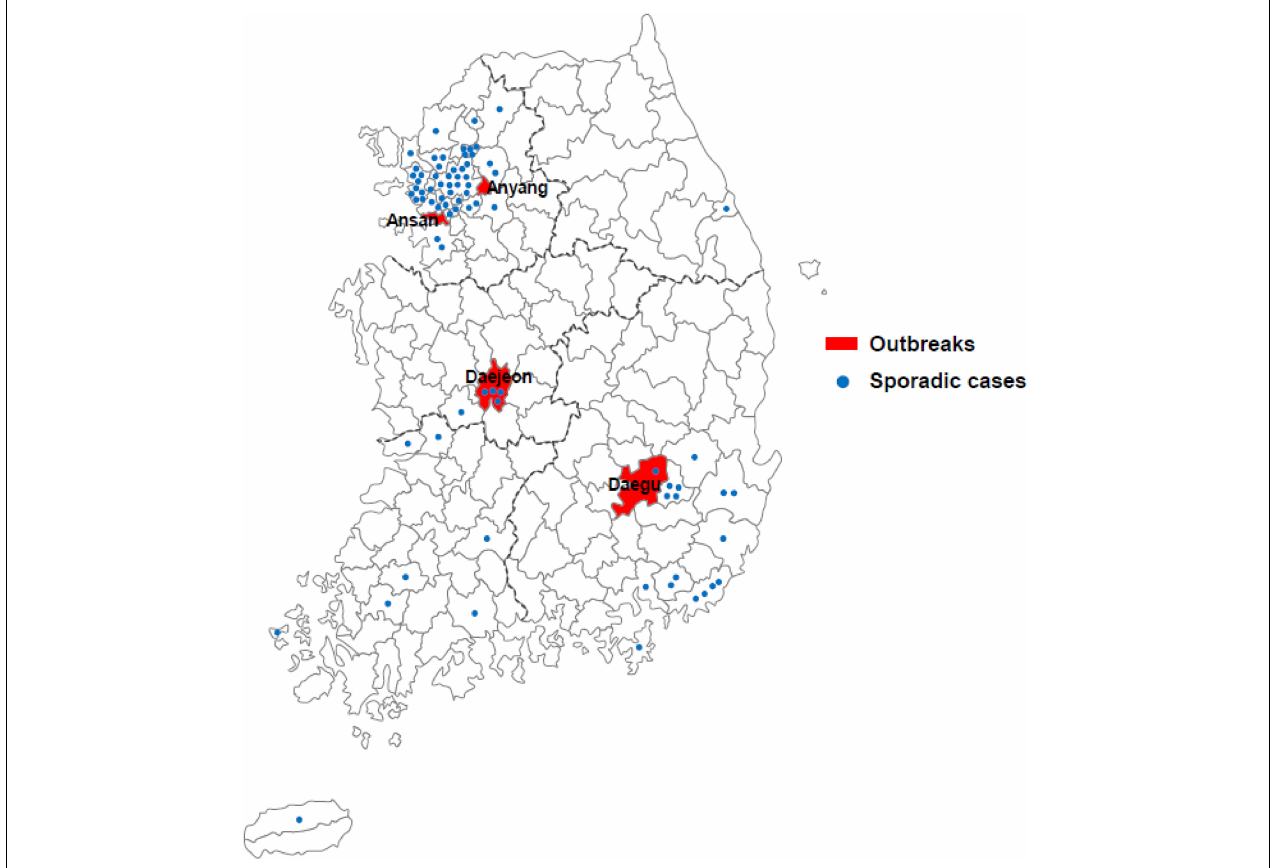
FIGURE 1 | Geographical distribution of cases of measles across South Korea in 2019. Measles outbreaks occurred in four regions of South Korea (Daegu, Ansan, Anyang, and Daejeon; red fill). Sporadic cases are represented by blue dots.